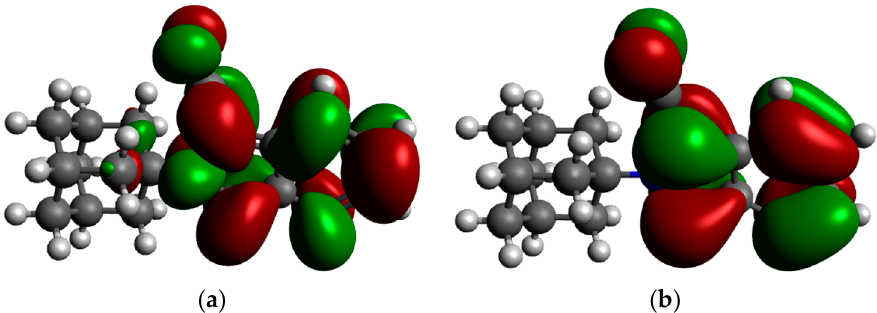
Figure 4. The frontier molecular orbitals of compound 1 calculated using B3LYP/6-311++G (d,p). ( a ) LUMO ( − 1.550 eV), ( b ) HOMO ( − 5.625 eV).